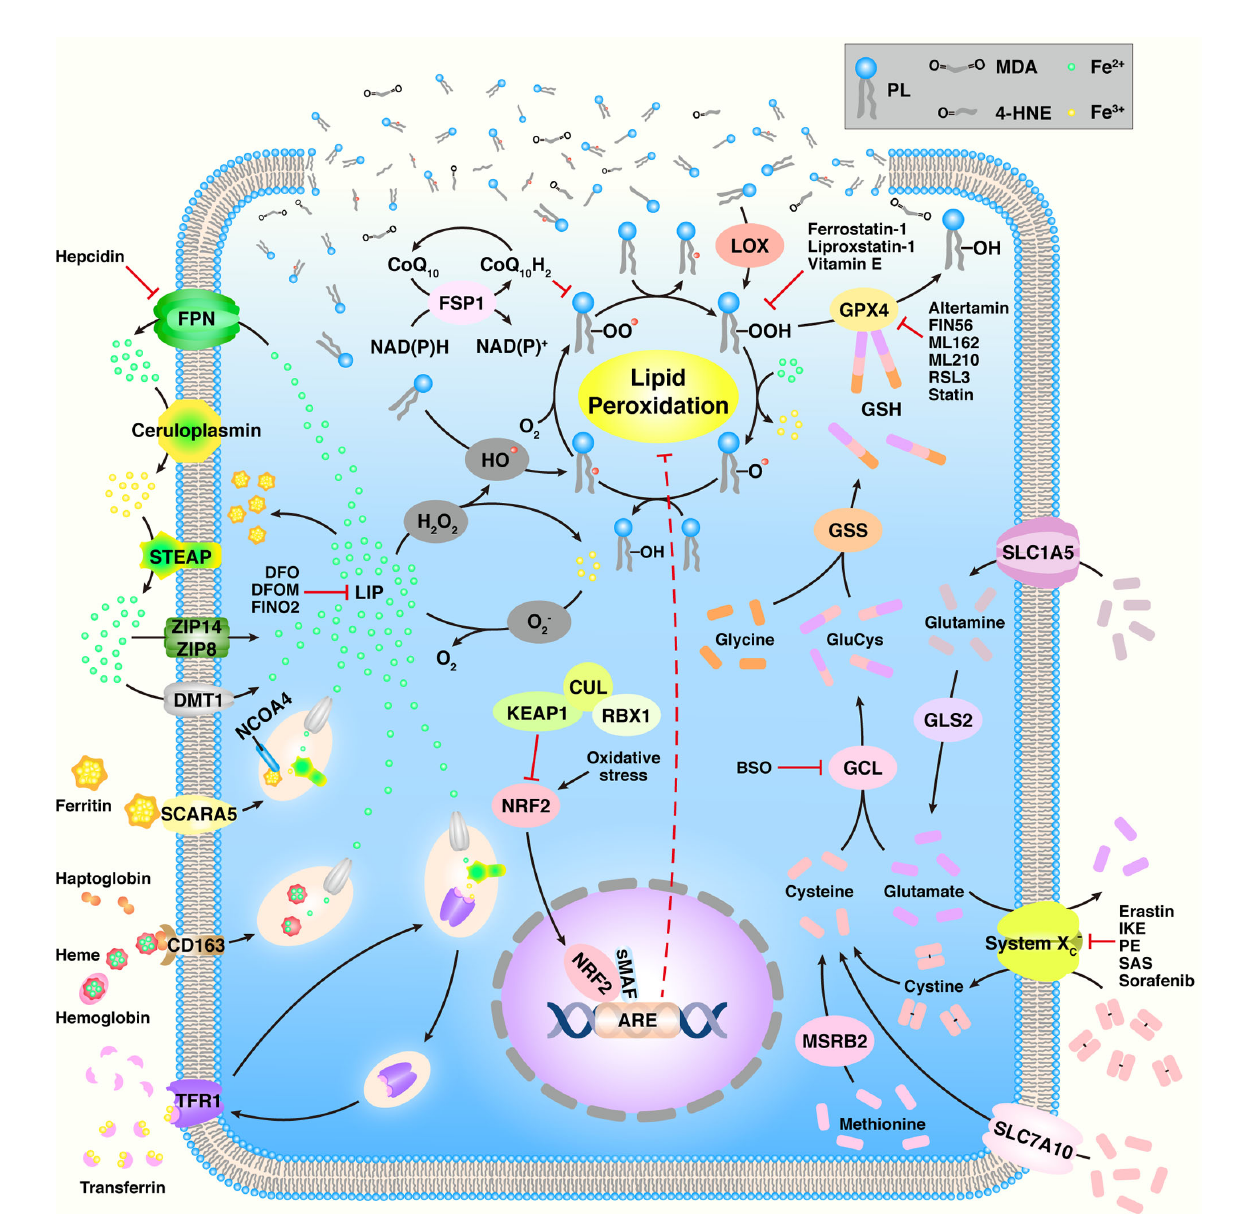
FIGURE 1 | An overview of ferroptosis. ARE, antioxidant response element; BSO, buthionine sulfoximine; CoQ 10 , coenzyme Q 10 ; CUL3, cullin3; DFO, deferoxamine; DFOM, desferrioxamine mesylate; DMT1, divalent metal transporter 1; FPN, ferroportin; FSP1, ferroptosis suppressor protein 1; GCL, glutamate-cysteine ligase; GLS2, glutaminase 2; GPX4, GSH peroxidase 4; GSH, glutathione; GSS, glutathione synthetase; 4-HNE, 4-hydroxynonenal; HO (cid:129) , hydroxyl radical; IKE, imidazole ketone erastin; KEAP1, Kelch-like ECH-associated protein 1; LIP, labile iron pool; LOX, lipoxygenase; MDA, malondialdehyde; MSRB2, methionine-R-sul fi de reductase B2; NCOA4, nuclear receptor coactivator 4; NRF2, nuclear factor erythroid 2-related factor 2; PE, piperazine erastin; PL, phospholipid; PL (cid:129) , PL radical species; PLO (cid:129) , PL alkoxyl radical; PLOH, PL alcohol; PLOO (cid:129) , PL peroxyl radical; PLOOH, PL hydroperoxide; RBX1, ring box protein 1; RSL3, RAS synthetic lethal 3; SAS, sulfasalazine; SCARA5, scavenger receptor class A member 5; sMAF, small Maf; SLC1A5, solute carrier family member 1 member A5; STEAP, six- transmembrane epithelial antigen of prostate; TFR1, transferrin receptor 1; ZIP8, Zrt- and Irt-like protein